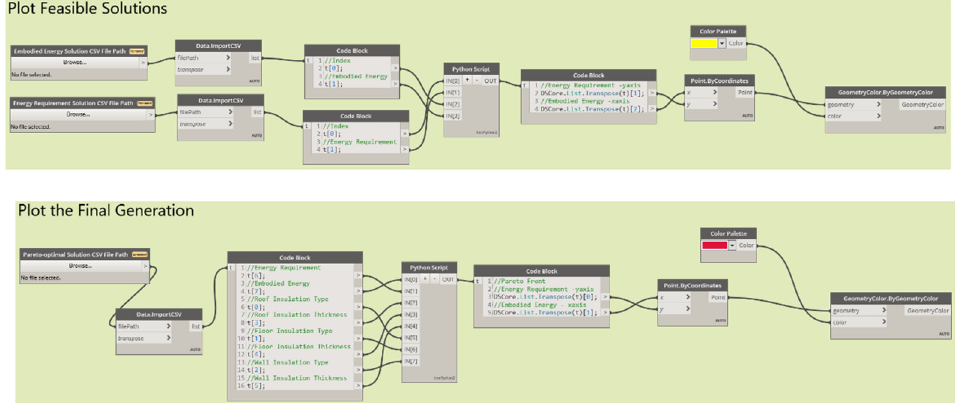
Figure 5. Dynamo Workflow for Data Visualisation.